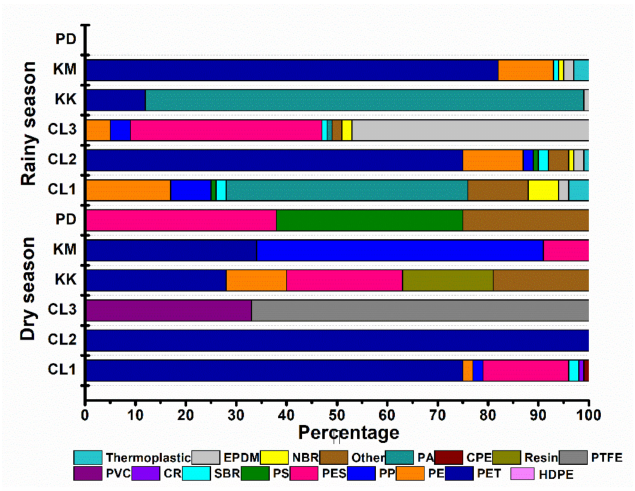
Figure 6. Polymer types found on the beaches in the eastern part of